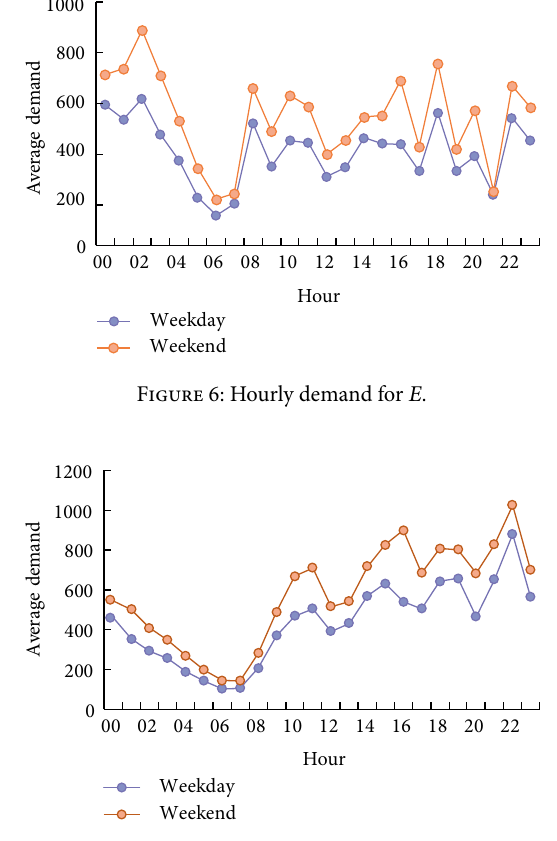
Figure 7: Hourly demand for 𝐺